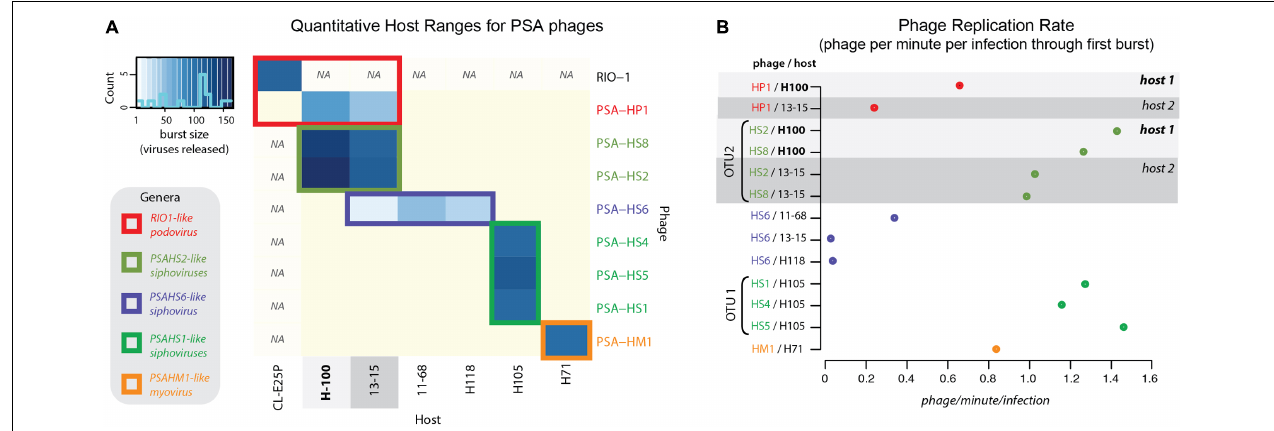
FIGURE 2 | (A) Quantitative host range analyses, whereby shade of blue reflects the burst size of the phage in each infection. Non-blue boxes indicate that the host was challenged with the phage, but that no infection occurred. Boxes with “na” indicate that this infection was not tested. Count bar inset in the upper left shows the distribution of burst sizes across all virus–host pairs represented in the heatmap. (B) Virus production rates for Helgoland Pseudoalteromonas phages and hosts. Rates are calculated as number of phage produced per infection during the first step of the one-step virus production curve (Supplementary Figure S6). Light and dark gray bands emphasize like hosts when “phage OTU” infection traits are contrasted, as referenced later in conceptual model proposed in Figure 7